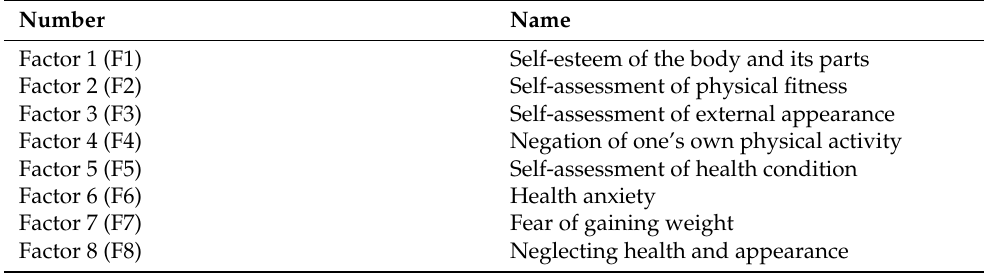
Table 3. A list of the names of the distinguished factors in the MBSRQ-PL